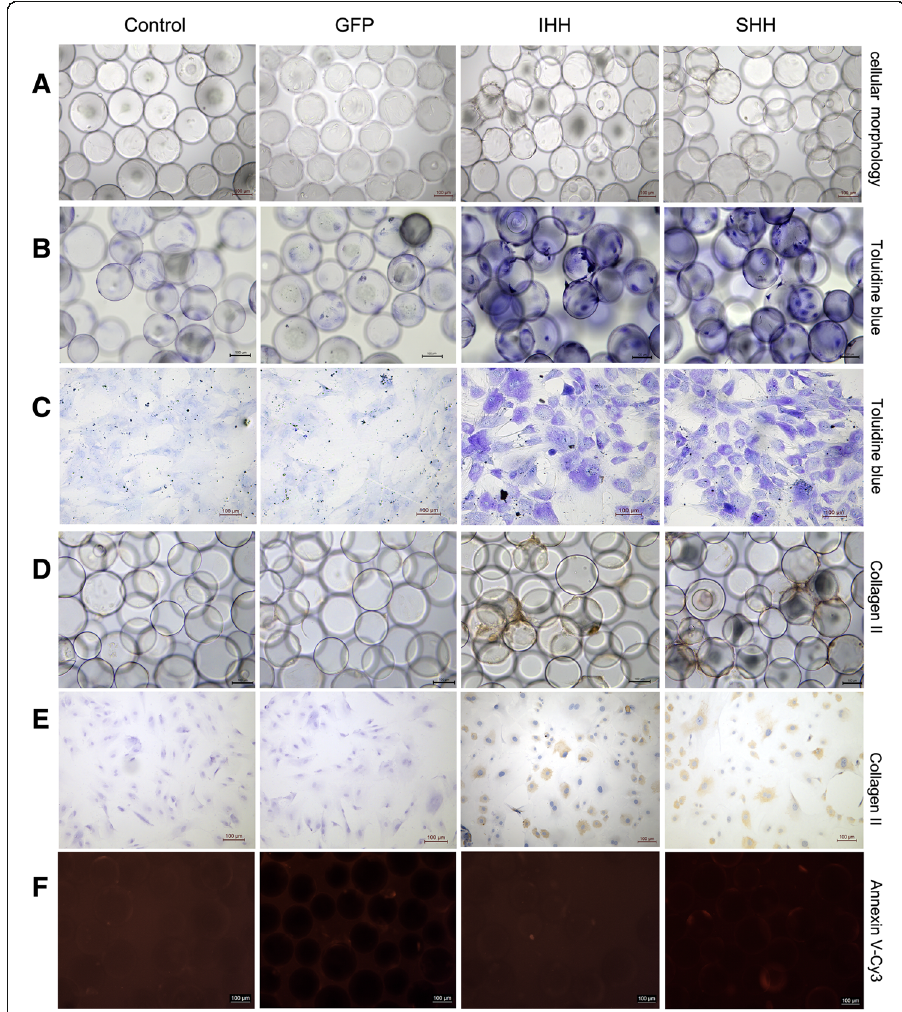
Fig. 7 Staining results for the process of differentiation induction in the RCCS environment. ( a ) Cellular morphology. ( b ) Toluidine blue staining on cell-microcarrier complexes. ( c ) Toluidine blue staining on cells after inoculation onto slides. ( d ) Collagen II immunohistochemical staining on cell-microcarrier complexes. ( e ) Collagen II immune-histochemical staining on cells after inoculation onto slides. ( f ) Annexin V-Cy3 immunofluorescence staining. (Bar = 100